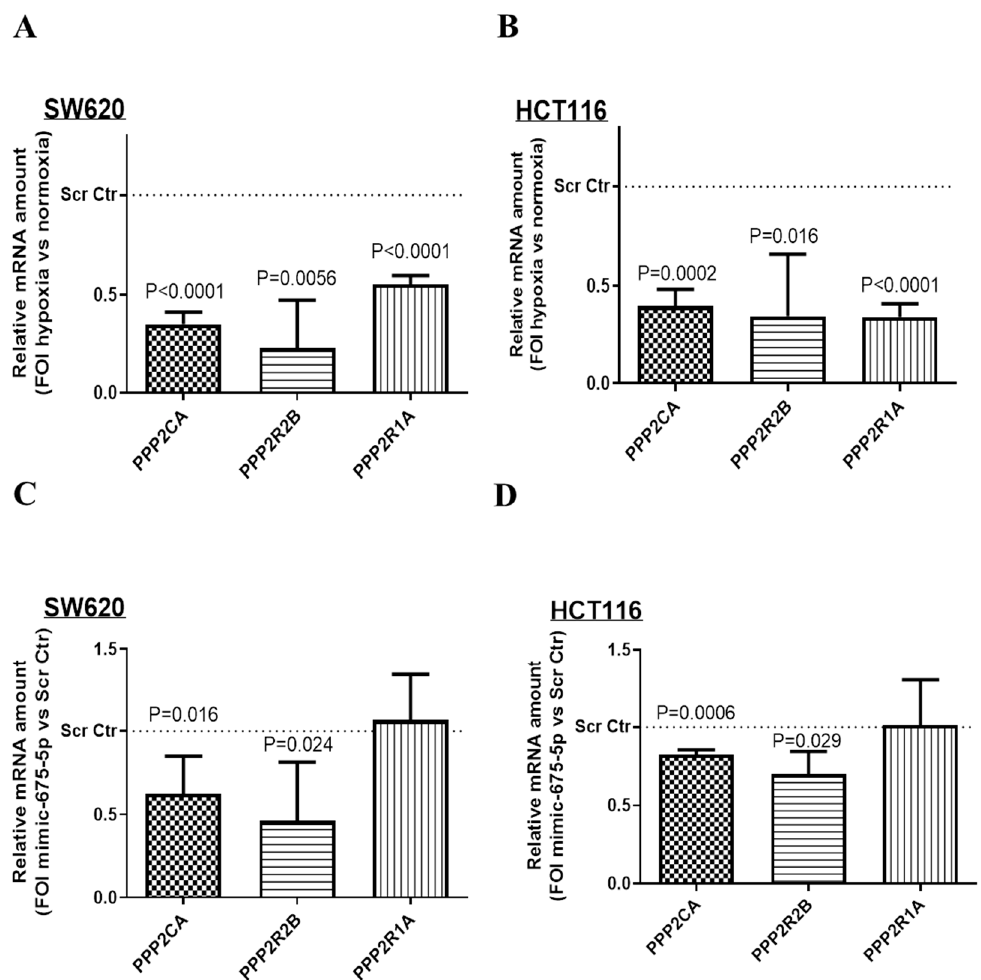
Figure 6. E ff ect of miR-675-5p on the phosphatases’ mRNA level. Real-time PCR for PP2CA, PP2R2B and PP2R1A in SW620 ( A ) and HCT116 ( B ) under normoxic condition or subjected to 18 h of hypoxic stimulation. Gene expression data were normalized for β -actin, ∆∆ ct is expressed as fold of increase (FOI) with respect to the expression in normoxic cells. Real-time PCR PP2CA, PP2R2B and PP2R1A in SW620 ( C ) and HCT116 ( D ) transfected with miR-675-5p mimic or scrambled negative control in normoxic conditions and subjected to 18 h of hypoxic stimulation. Gene expression data were normalized for β -actin, ∆∆ ct is expressed as fold of increase (FOI) with respect to the expression in scrambled negative control transfected cells. Data are expressed as the mean ± SD of three independent experiments and p -values are indicated in the